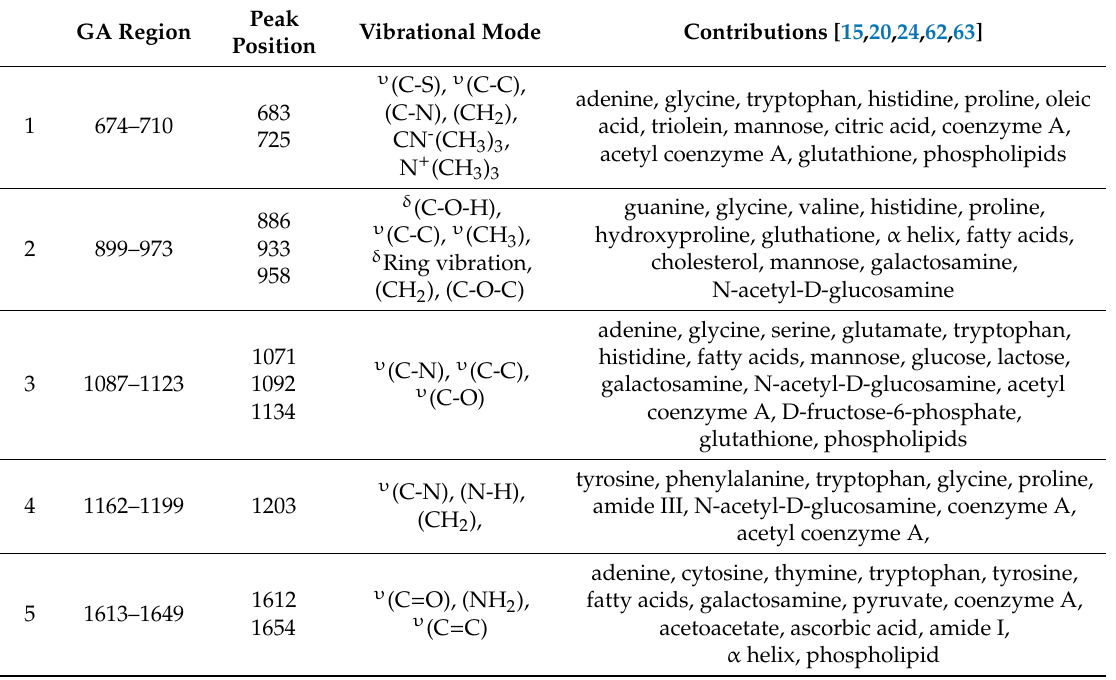
Table 2. Tentative assignments of the most important regions in the SERS spectrum of blood serum for the discrimination between AD and HC, as determined by GA.